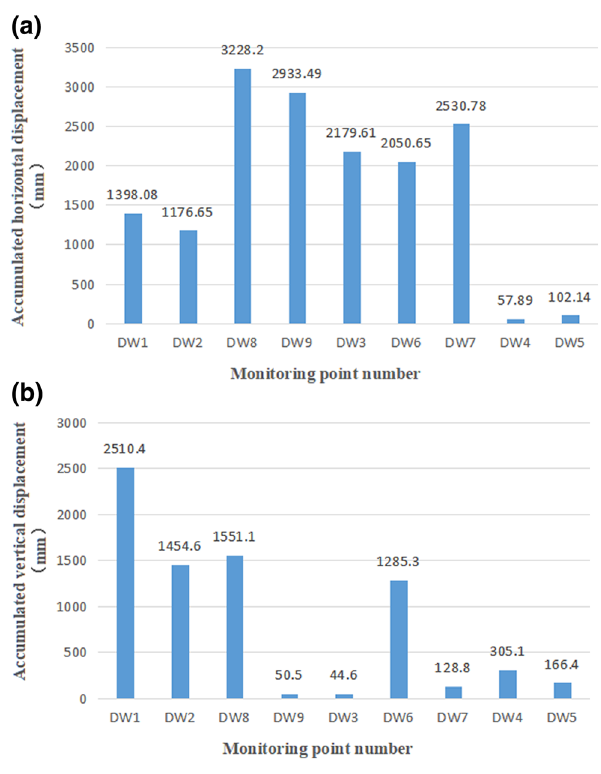
c Fig. 8 Diagrams of data on displacement depths obtained through